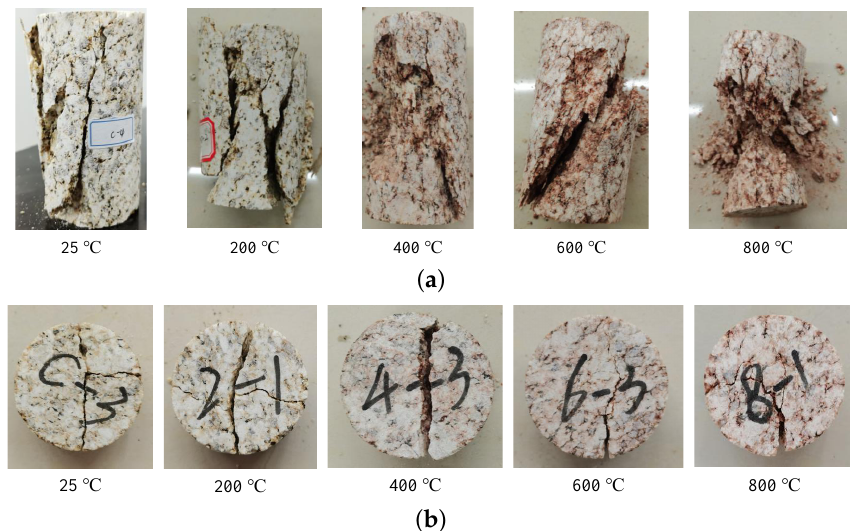
Figure 7. Specimens after damage by uniaxial compression and Brazilian splitting tests. ( a ) Uniaxial compression test; ( b ) Brazilian splitting test.